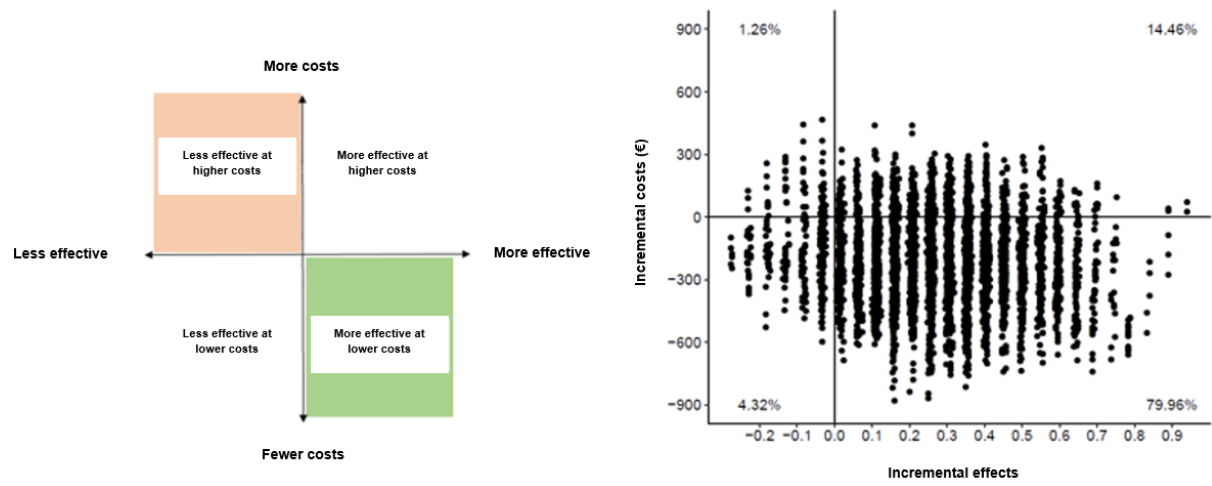
Figure 1. Generic cost-effectiveness plane (left) and an example illustrating the bootstrapped incremental cost-effectiveness ratios plotted (right).